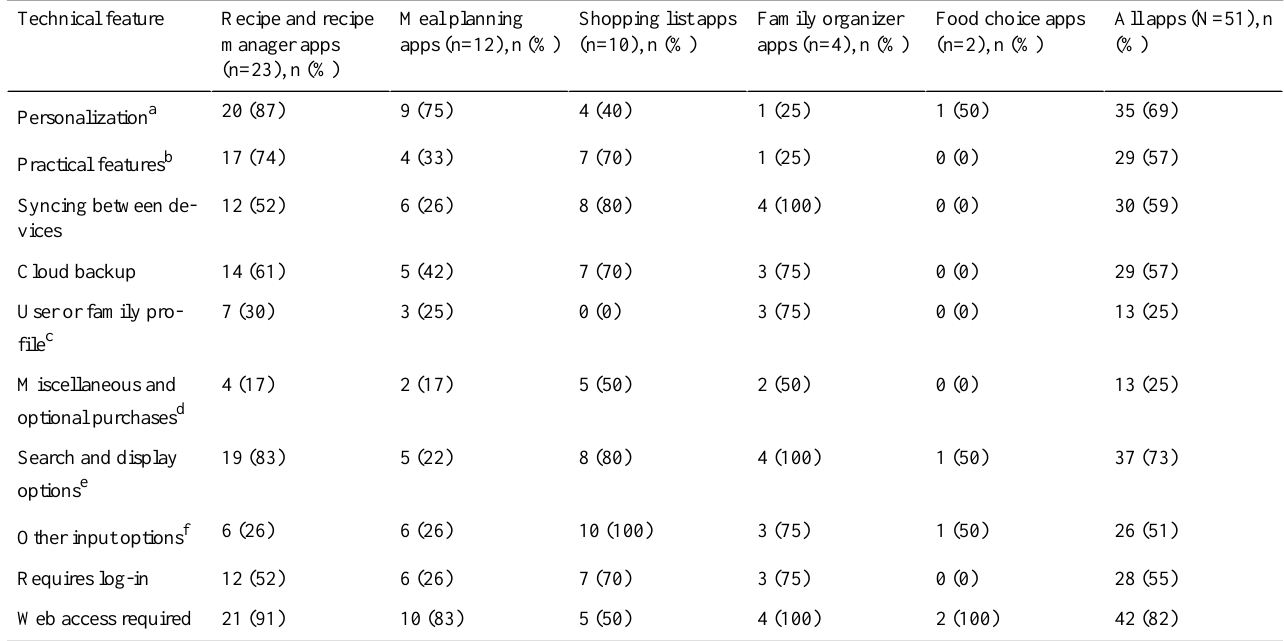
Table 3. Technical features presented by app type and across all